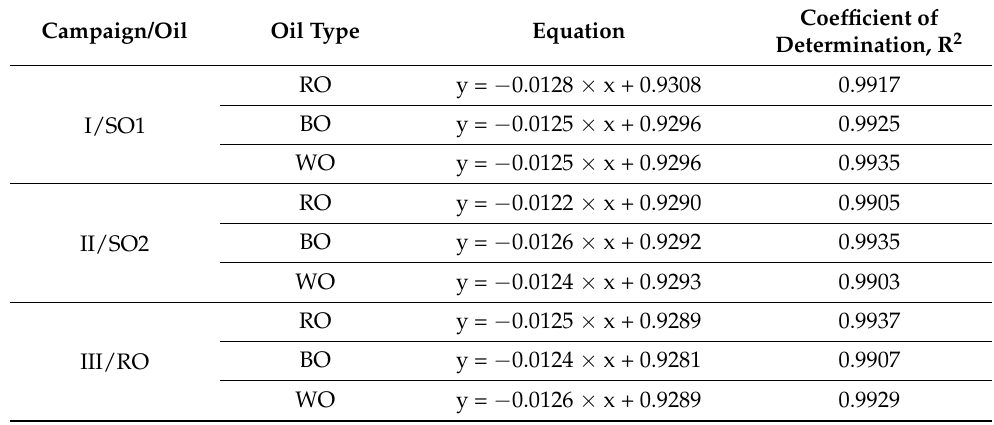
Table 3. Mathematical correlation of vegetable oils density (g × cm − 3 ) with temperature ( ◦ C). Campaign/Oil